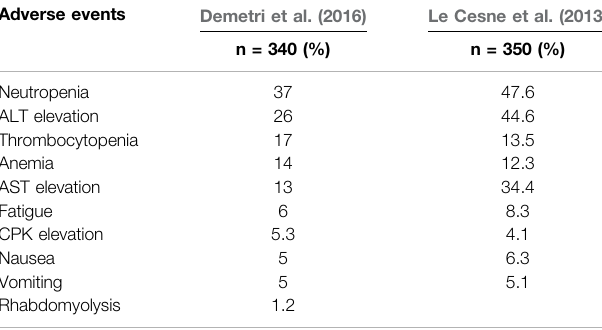
TABLE 2 | Safety pro fi le of trabectedin (NCI-CTC Grade3 or 4